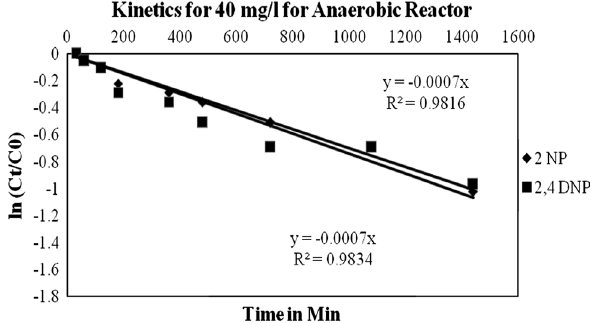
Fig. 13 Kinetics for 40 mg/l nitrophenol loading